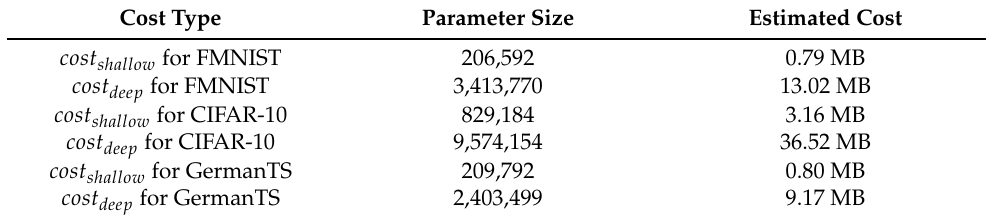
Table 3. The estimated unit cost of